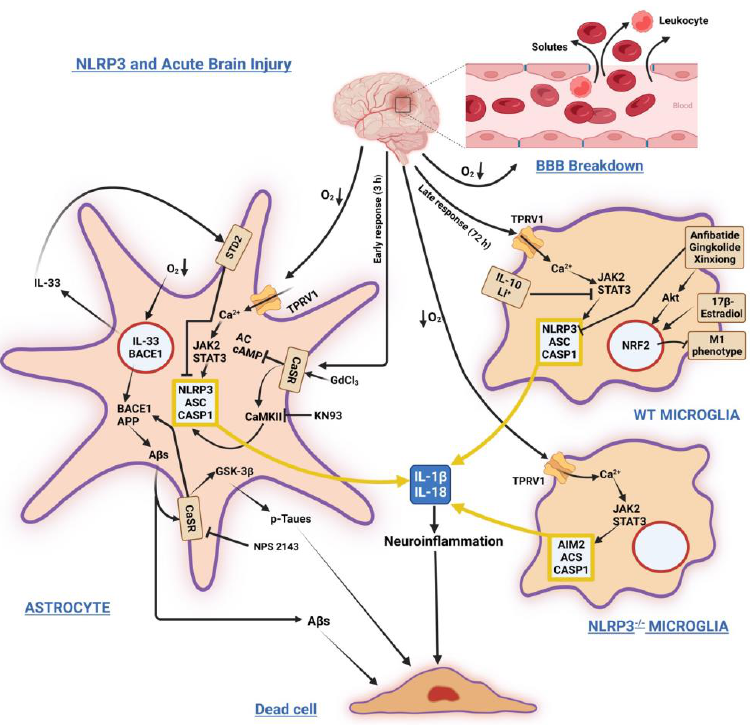
Figure 1 sums up the main signaling pathways involving NLRP3 in acute brain inju- ries.